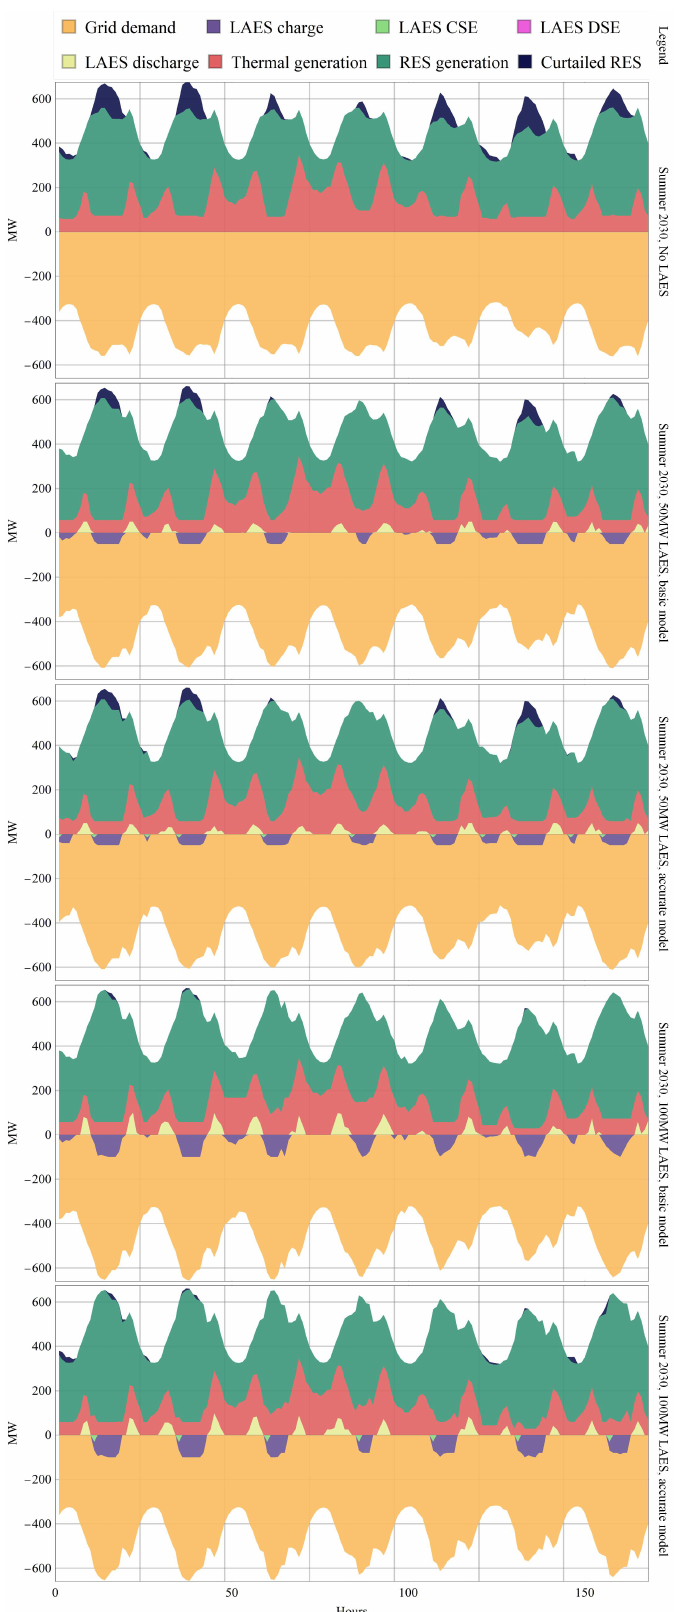
Figure 7. Power balance, sample week of summer